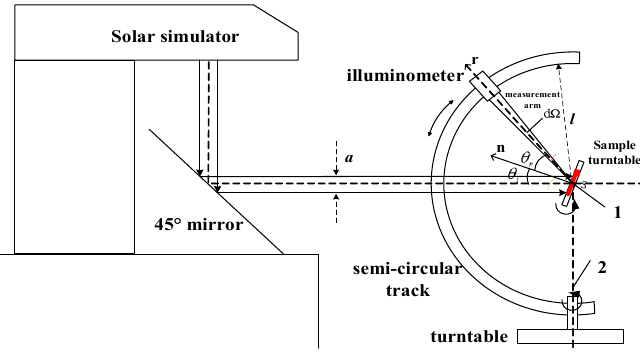
Figure 4. The measurement device of BRDF on the Surface of the Solar Panel.